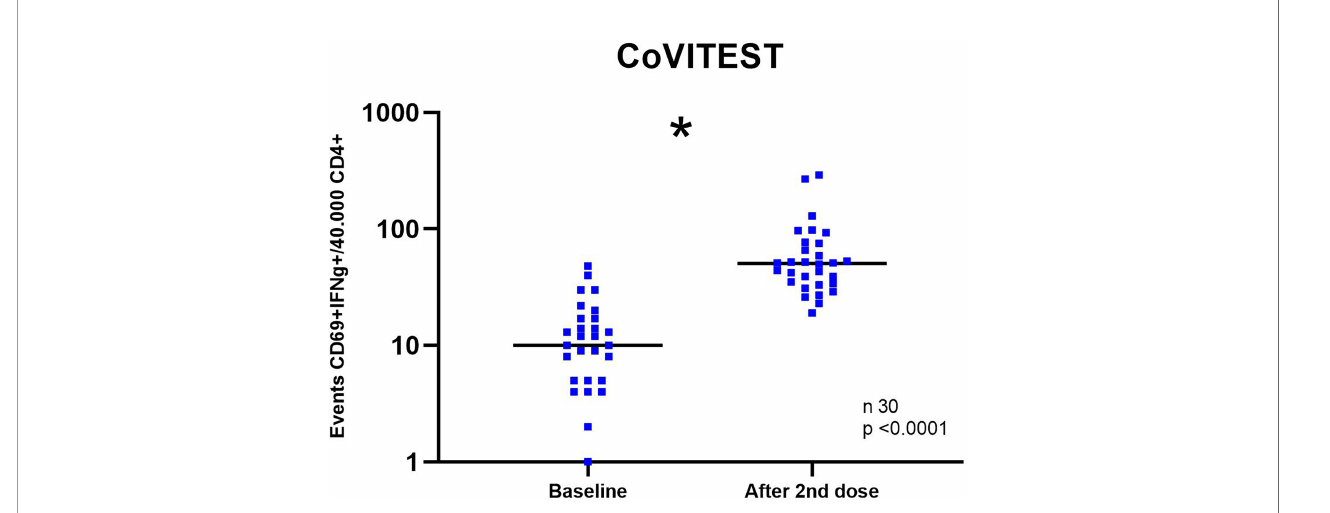
FIGURE 5 | SARS-CoV-2-speci fi c T cell response at baseline and two weeks after the second vaccine dose in healthy unexposed donors. SARS-CoV-2 speci fi c T cells (CD4+ IFN- g + CD69+) after stimulation with spike and nucleocapsid SARS-CoV-2 peptide pools at baseline and two weeks after the second vaccine dose. Each dot represents an individual subject. *Statistical comparison at baseline and post-vaccination was performed with the Wilcoxon test.